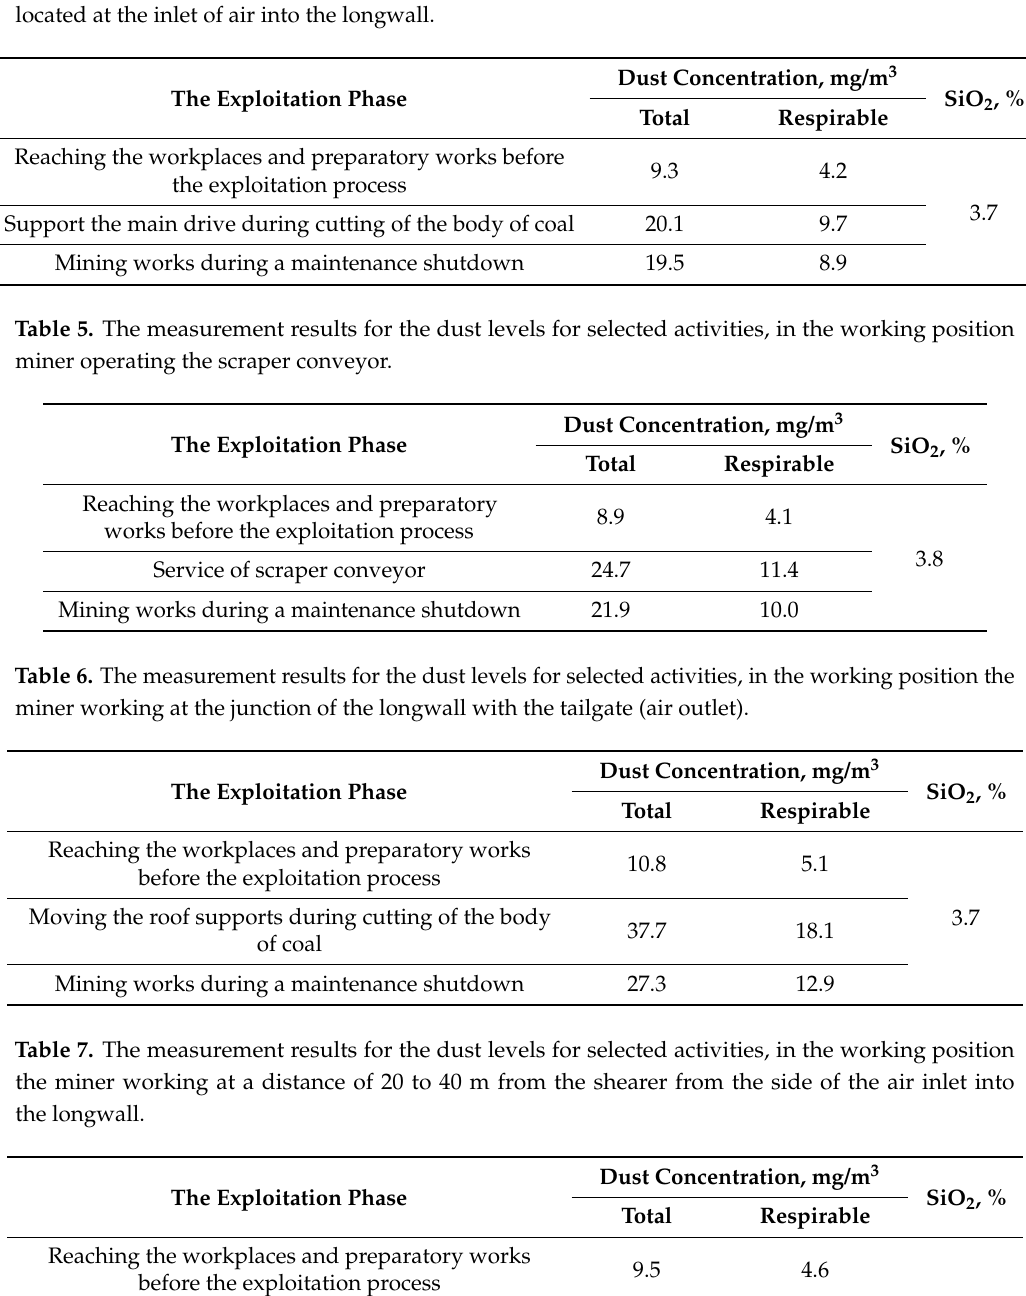
Table 4. The measurement results for the dust levels for selected activities, in the working position located at the inlet of air into the longwall.